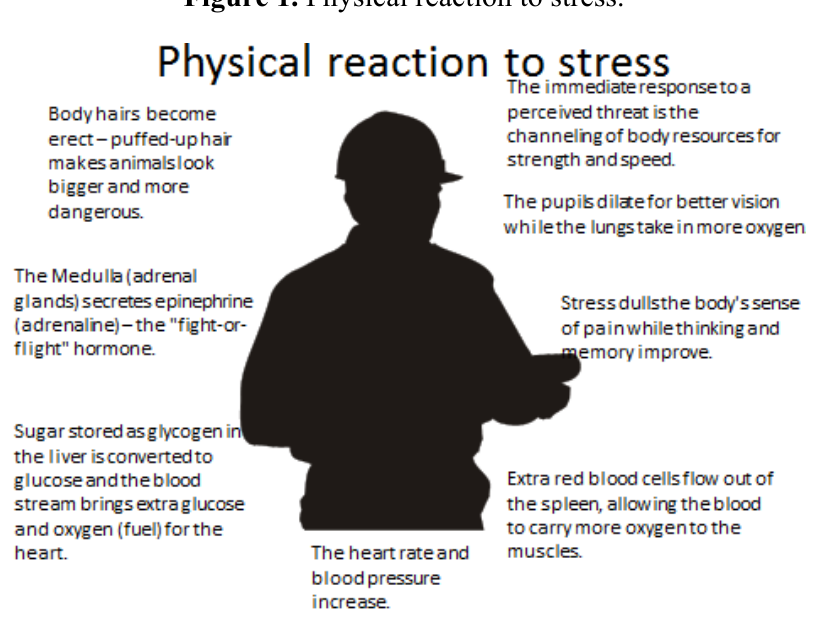
Figure 1. Physical reaction to stress.